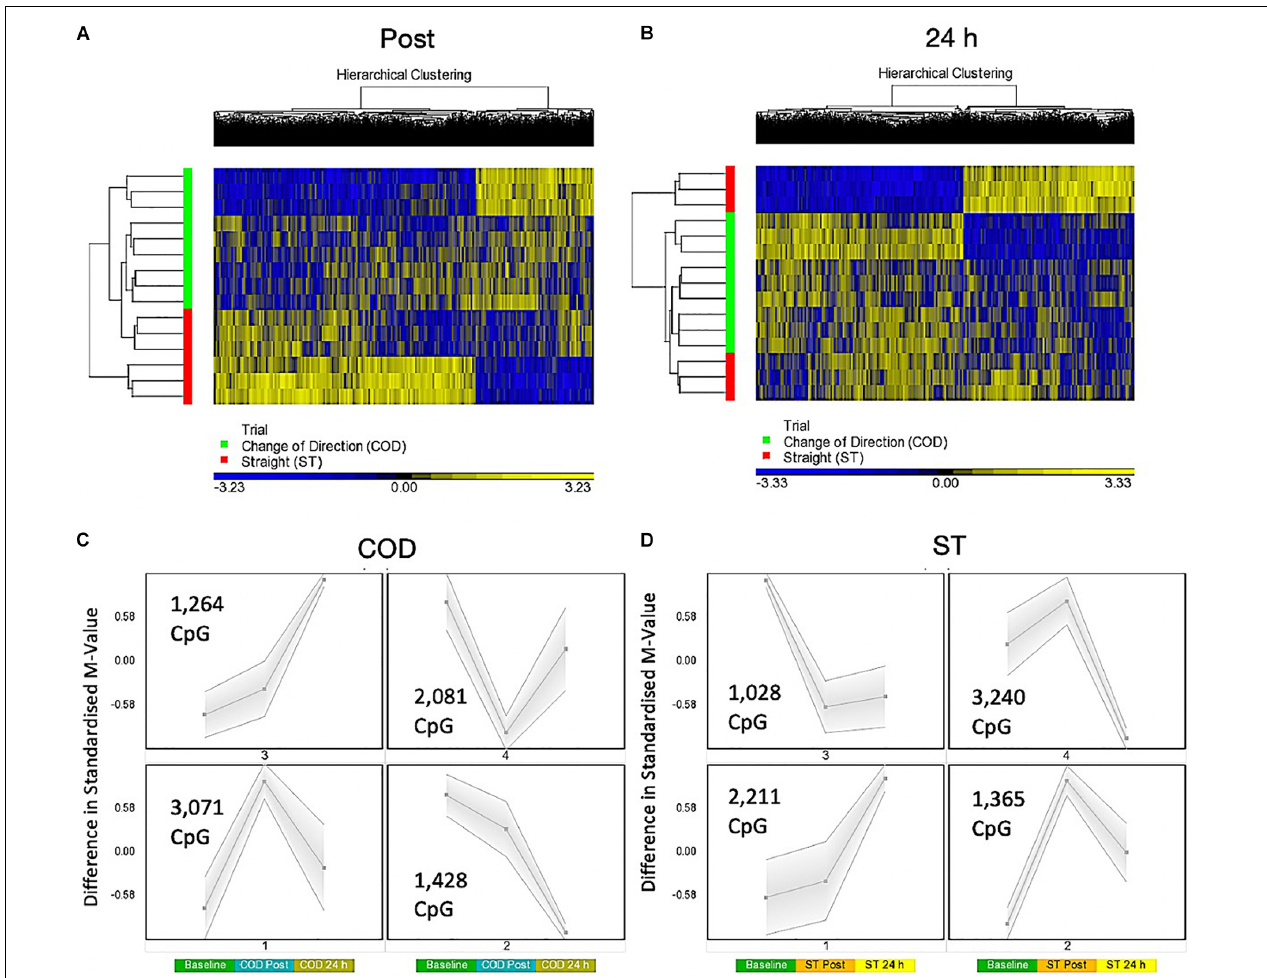
FIGURE 3 | (A) Hierarchical heat map for analysis of DMPs in COD vs. ST trials 30 min (post) exercise. (B) Hierarchical heat map for analysis of DMPs in COD vs. ST trials 24 h post exercise. (C) SOM temporal analysis of DMPs over exercise time in COD exercise trial at baseline, post and 24 h post exercise. (D) SOM temporal analysis of DMPs over exercise time in ST exercise trial at baseline, post and 24 h post exercise.